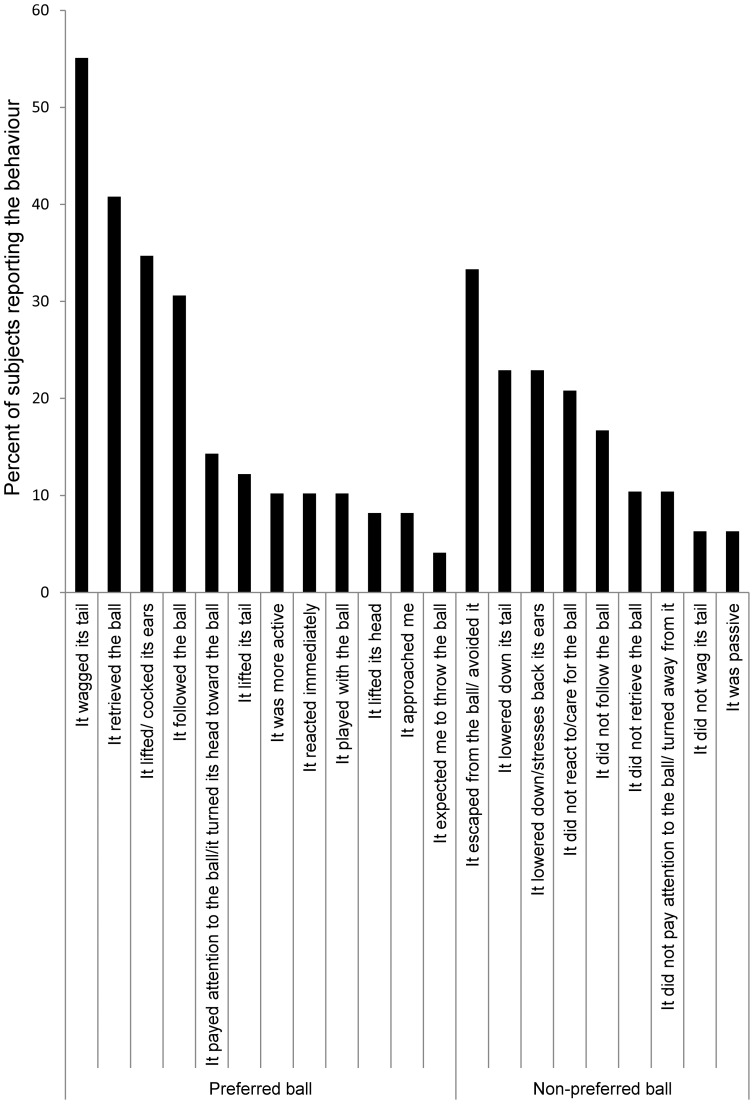
Percentage of subjects reporting the given behaviours when describing on what behaviours they based their emotion-attribution in case of the ‘preferred’ and the ‘non-preferred’ ball.